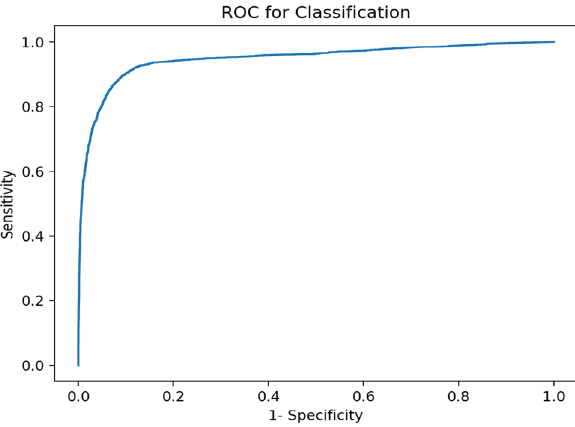
Figure 4. The ROC on the test set for the classification